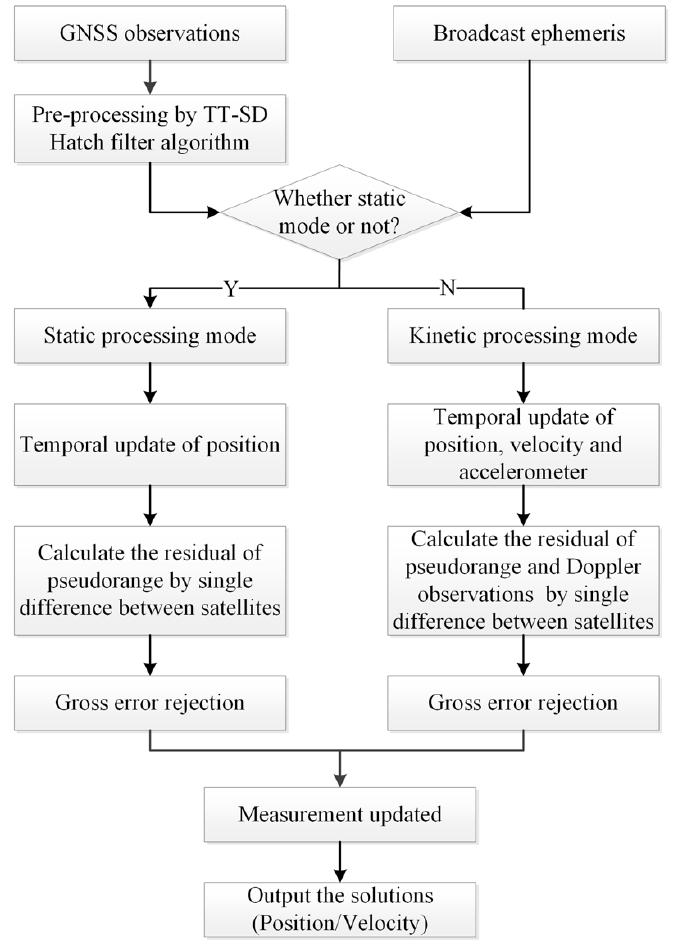
Figure 3. The procedure of the positioning algorithm in this study